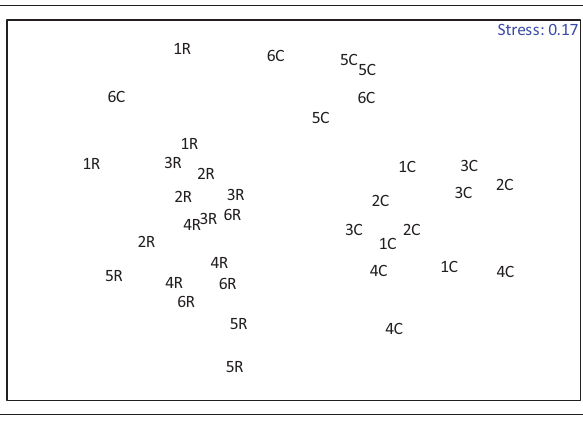
FIGURE 1-A4: Non-metric multidimensional scaling plot indicating the similarity of plant assemblages among replicates of control and rehabilitated